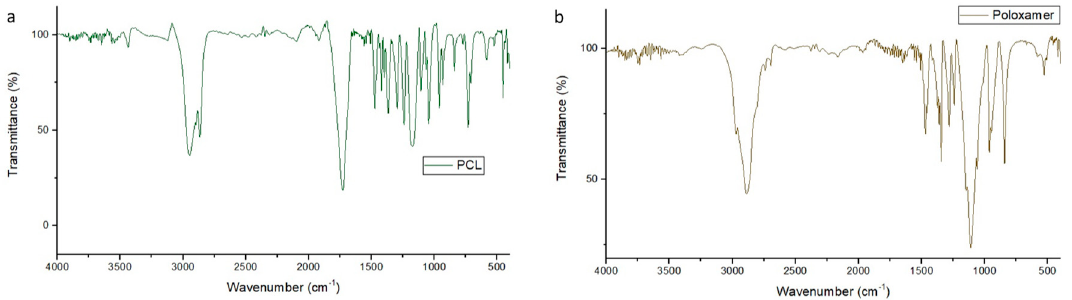
Figure 8. FT-IR spectra. ( a ) PCL, ( b )